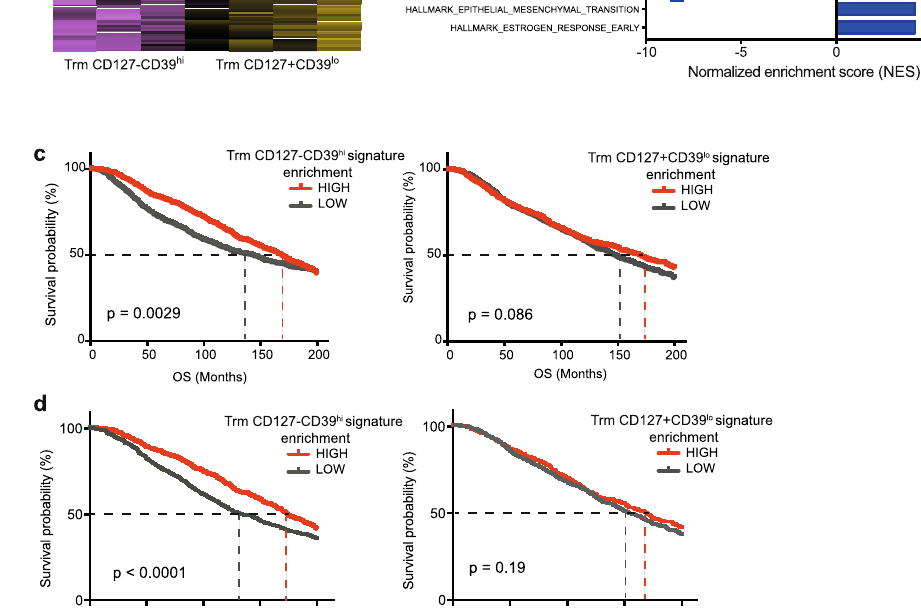
Fig. 3 CD127 − CD39 hi Trm cells de fi ne a signature of increased survival in BC. a Heatmap of differentially expressed genes (FDR < 0.05) between FACS- sorted CD127 − CD39 hi ( n = 3) vs. CD127 + CD39 lo ( n = 4) CD8 + Trm cells subsets from tumor samples ( n = 6 biologically independent samples), as obtained by RNA-seq. Selected differentially expressed genes are indicated. b Bar plot of manually curated signatures that differed signi fi cantly (adjusted p value < 0.05) as obtained by gene set enrichment analysis (GSEA) of RNA-seq data in a . Kaplan – Meier overall survival (OS) curves in the METABRIC dataset for all BC patients ( c ; n = 1894) and for luminal-like tumors only ( d ; n = 1436). The mean z -score value was used to classify tumor samples into LOW and HIGH expression groups. p values were calculated by applying the log-rank (Mantel – Cox) test. Dotted lines indicate the time at which 50% of the cohort was still free of the